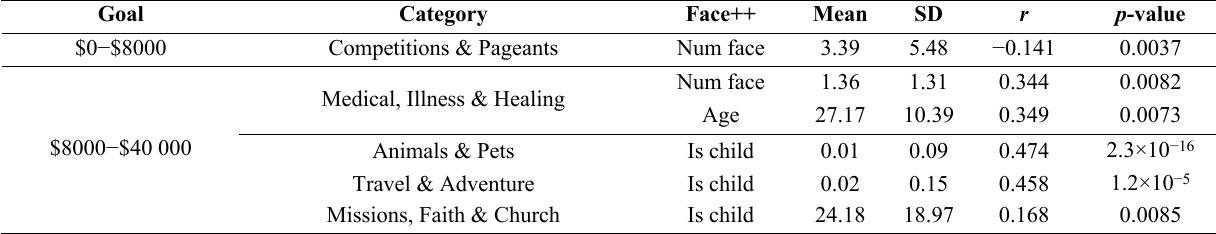
Table 4 Facial features that have significant influences.